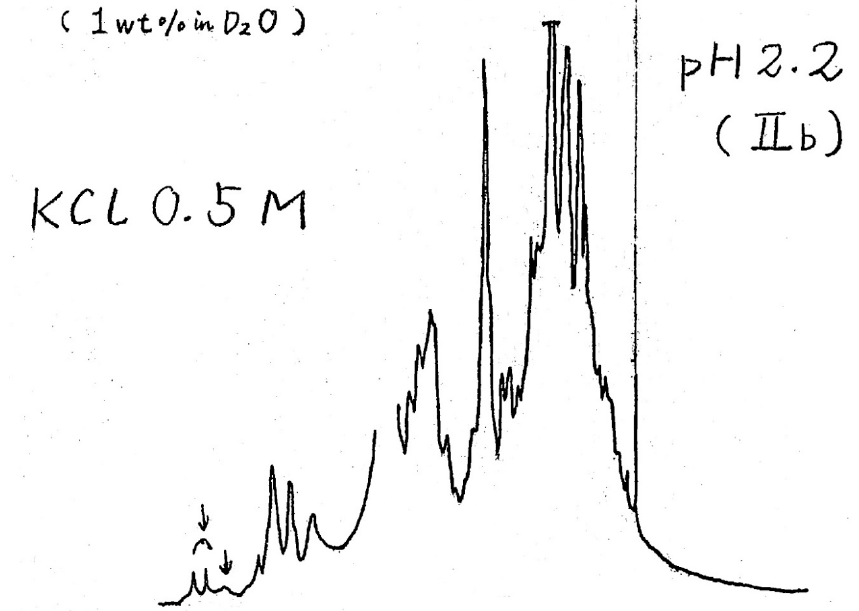
Figure 1. A copy of the original 1D 1H-NMR spectrum of Cytochrome c in the Molten Globule state (initially called state IIb in Wada’s laboratory). The spectrum was measured on December 4th, 1980, with a 360 MHz NMR spectrometer at the Institute for Protein Research, Osaka University. The arrows on the left side show peaks assigned to aromatic protons exhibiting features similar to those in a random coil state (by courtesy of Prof. K. Nagayama). Biomolecules 2019 , 9 , x